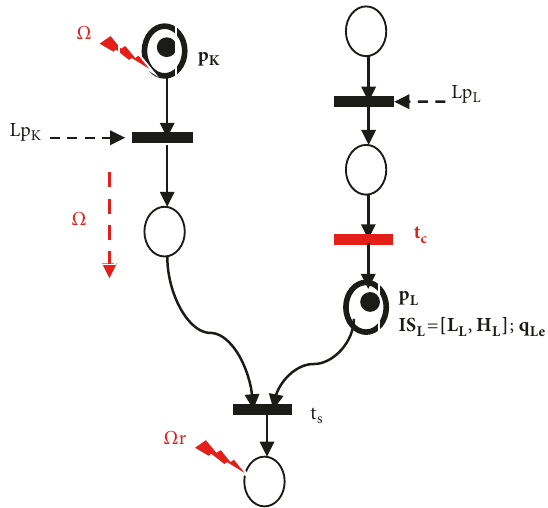
Figure 12: Propagation of disturbance on two parallel paths.